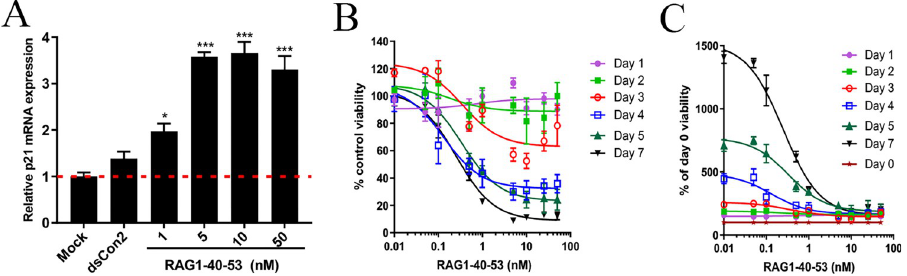
Fig 1. RAG1-40-53 induced p21 mRNA expression and caused a cytostatic effect in ARPE-19 cells. (A) ARPE-19 cells were transfected with the indicated duplex for 72 hours and mRNA expression of p21 was evaluated by RT-qPCR after RNA isolation from the treated cells and reverse transcription to convert the RNA into cDNA. (B) ARPE-19 cells were transfected with RAG1-40-53 at the indicated concentrations (ranging from 0.01, 0.05, 0.1, 0.5, 1,5, 10, 25, to 50 nM) or mock transfected for a duration ranging from 1 to 7 days. Viable cells were counted by using a CCK-8 kit and plotted as % of control treatment (B) and % of before transfection (day 0) (C). Error bars represent the mean SEM of two independent experiments. � P < 0.05, ��� P <